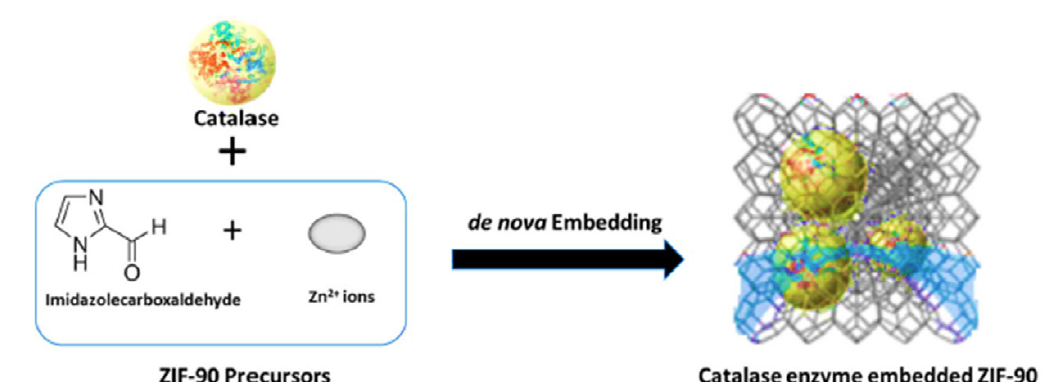
Figure 1. De novo approach for enzyme/ZIF-90 embedded catalyst, in which the catalase enzyme was encapsulated inside the MOF. Reproduced with permission from reference [35], copyright (2015), ACS Publication.